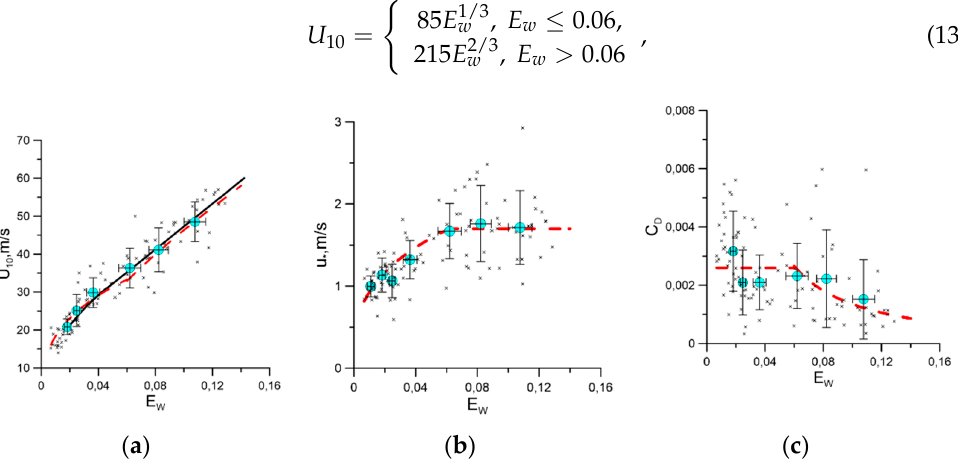
Figure 6. Comparison of the surface wind speed ( a ), the wind friction velocity ( b ), and drag coefficient of the ocean surface ( c ), retrieved from the data of falling GPS-dropsondes. Small symbols are the results of calculations for individual statistical ensembles composed of velocity profiles measured under approximately the same conditions, large symbols are averaged values, lines of approximation by (13)–(15) are on the right, middle and left panels, respectively. The dotted line on the left panel is the GMF from [19].